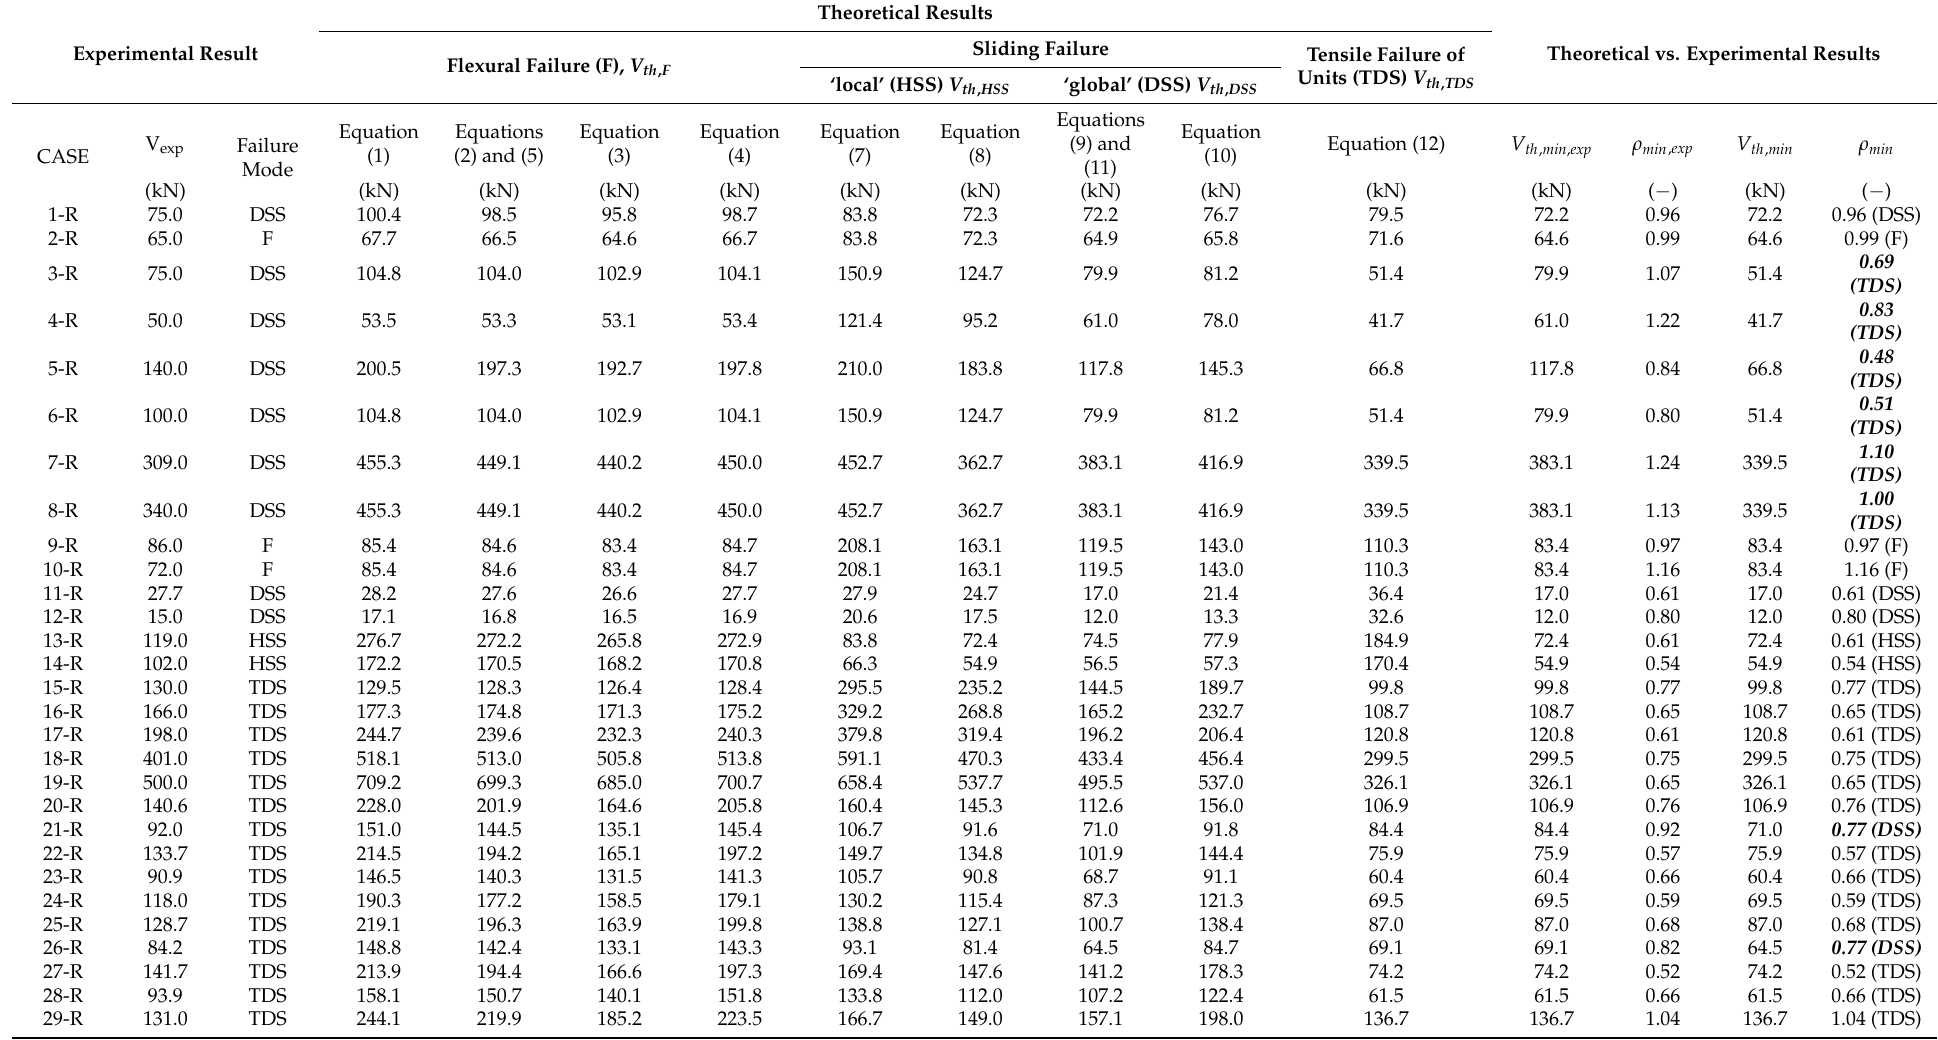
Table 6. Theoretical results and comparison with the experimental results for regular masonry